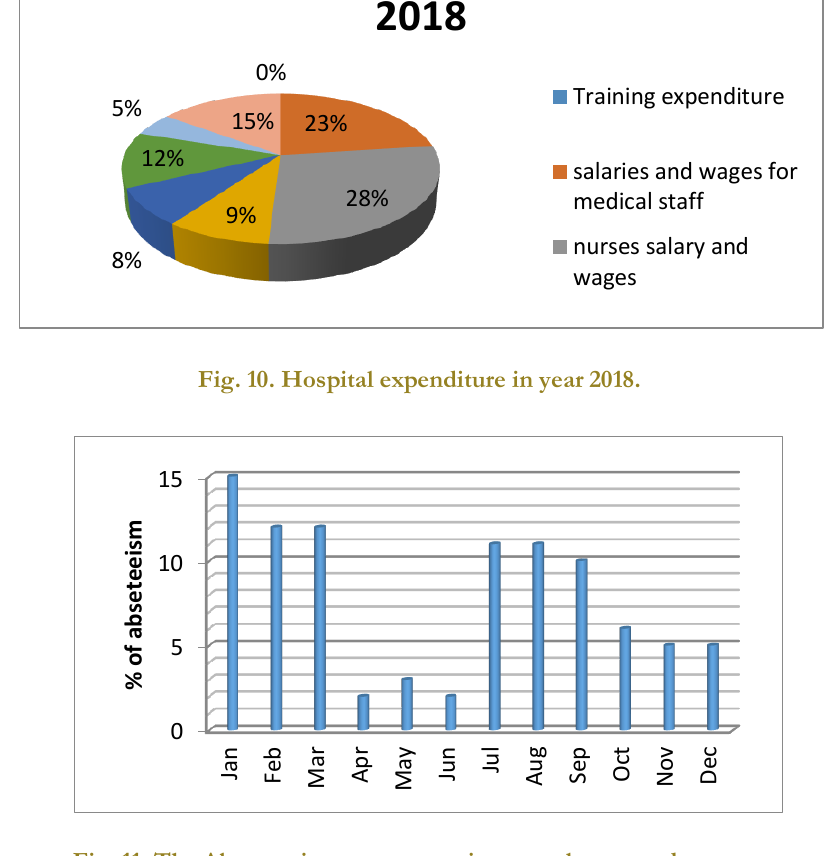
Fig. 11. The Absenteeism percentage in general surgery